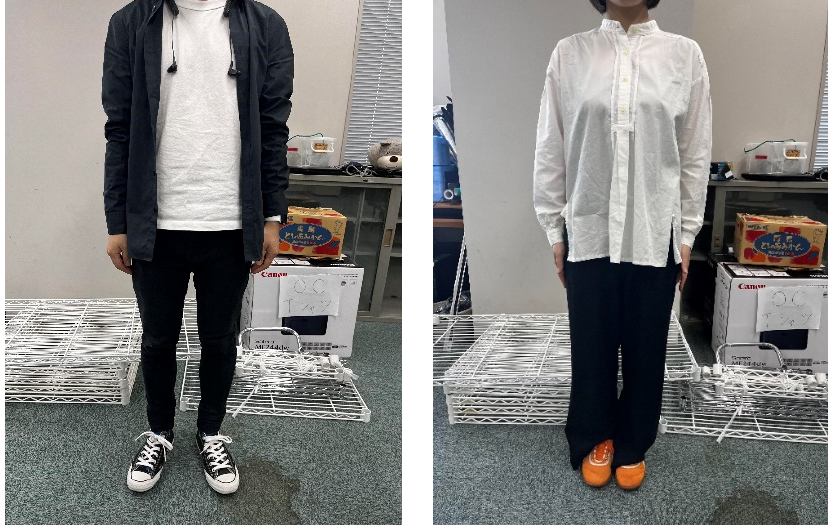
Figure 10. Subject’s clothes.